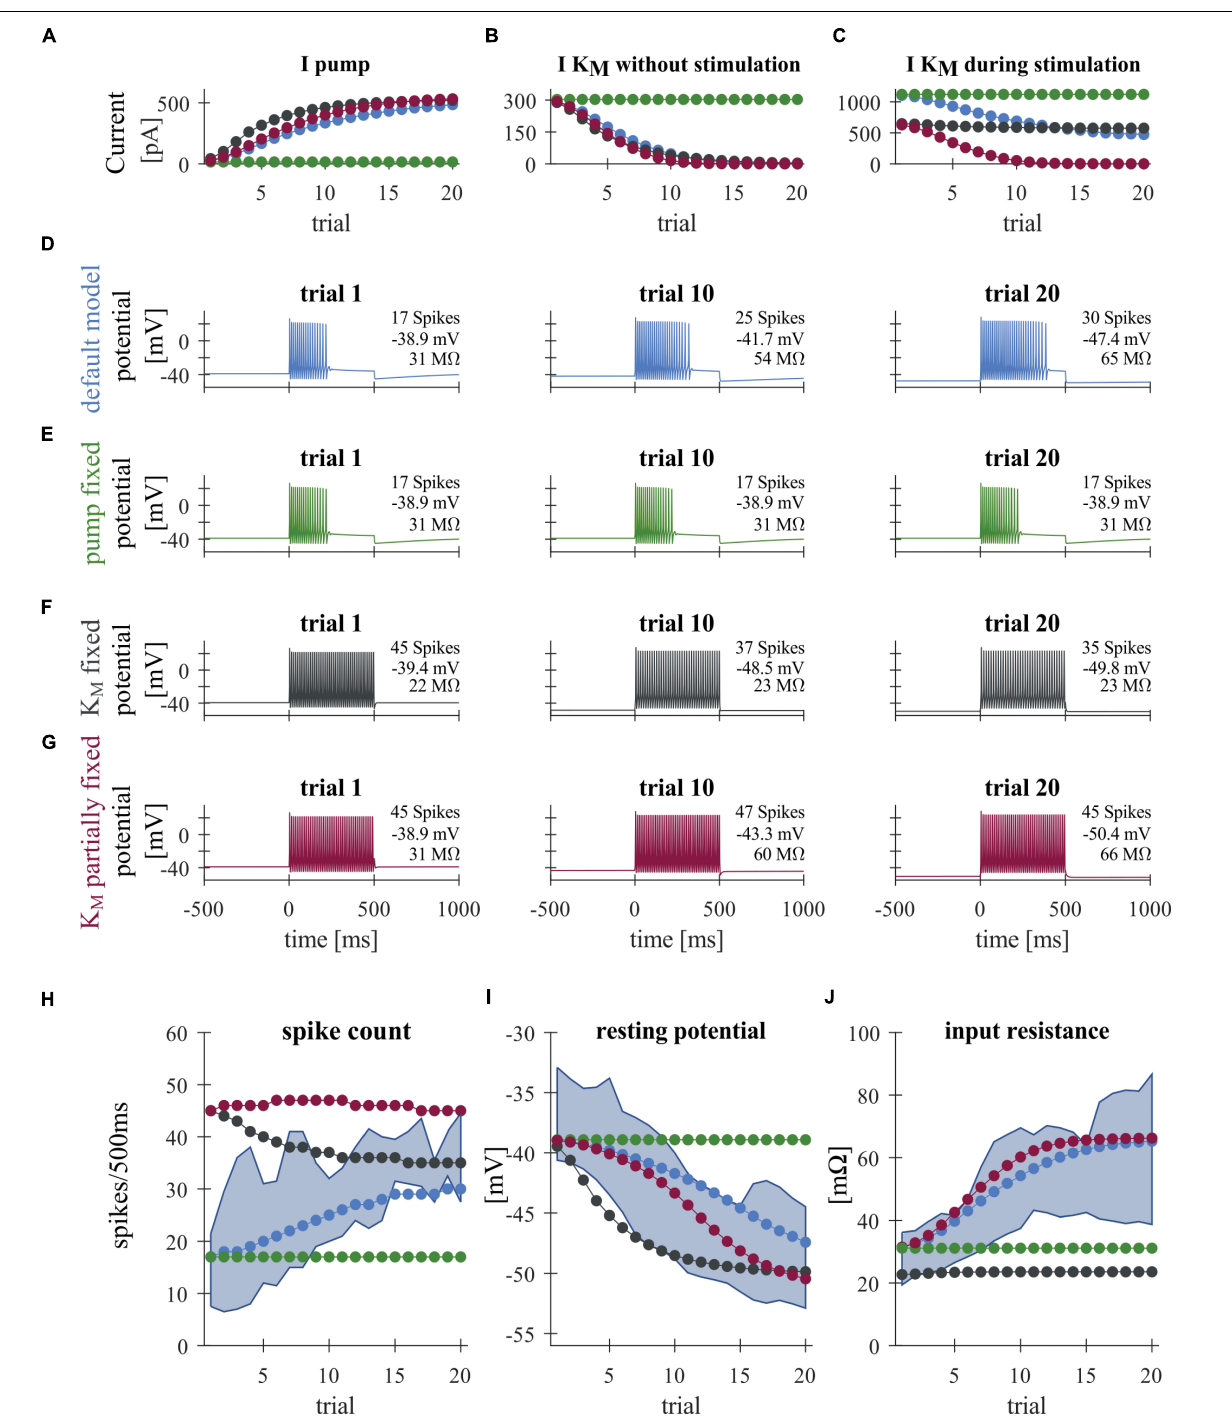
Frontiers in Physiology |